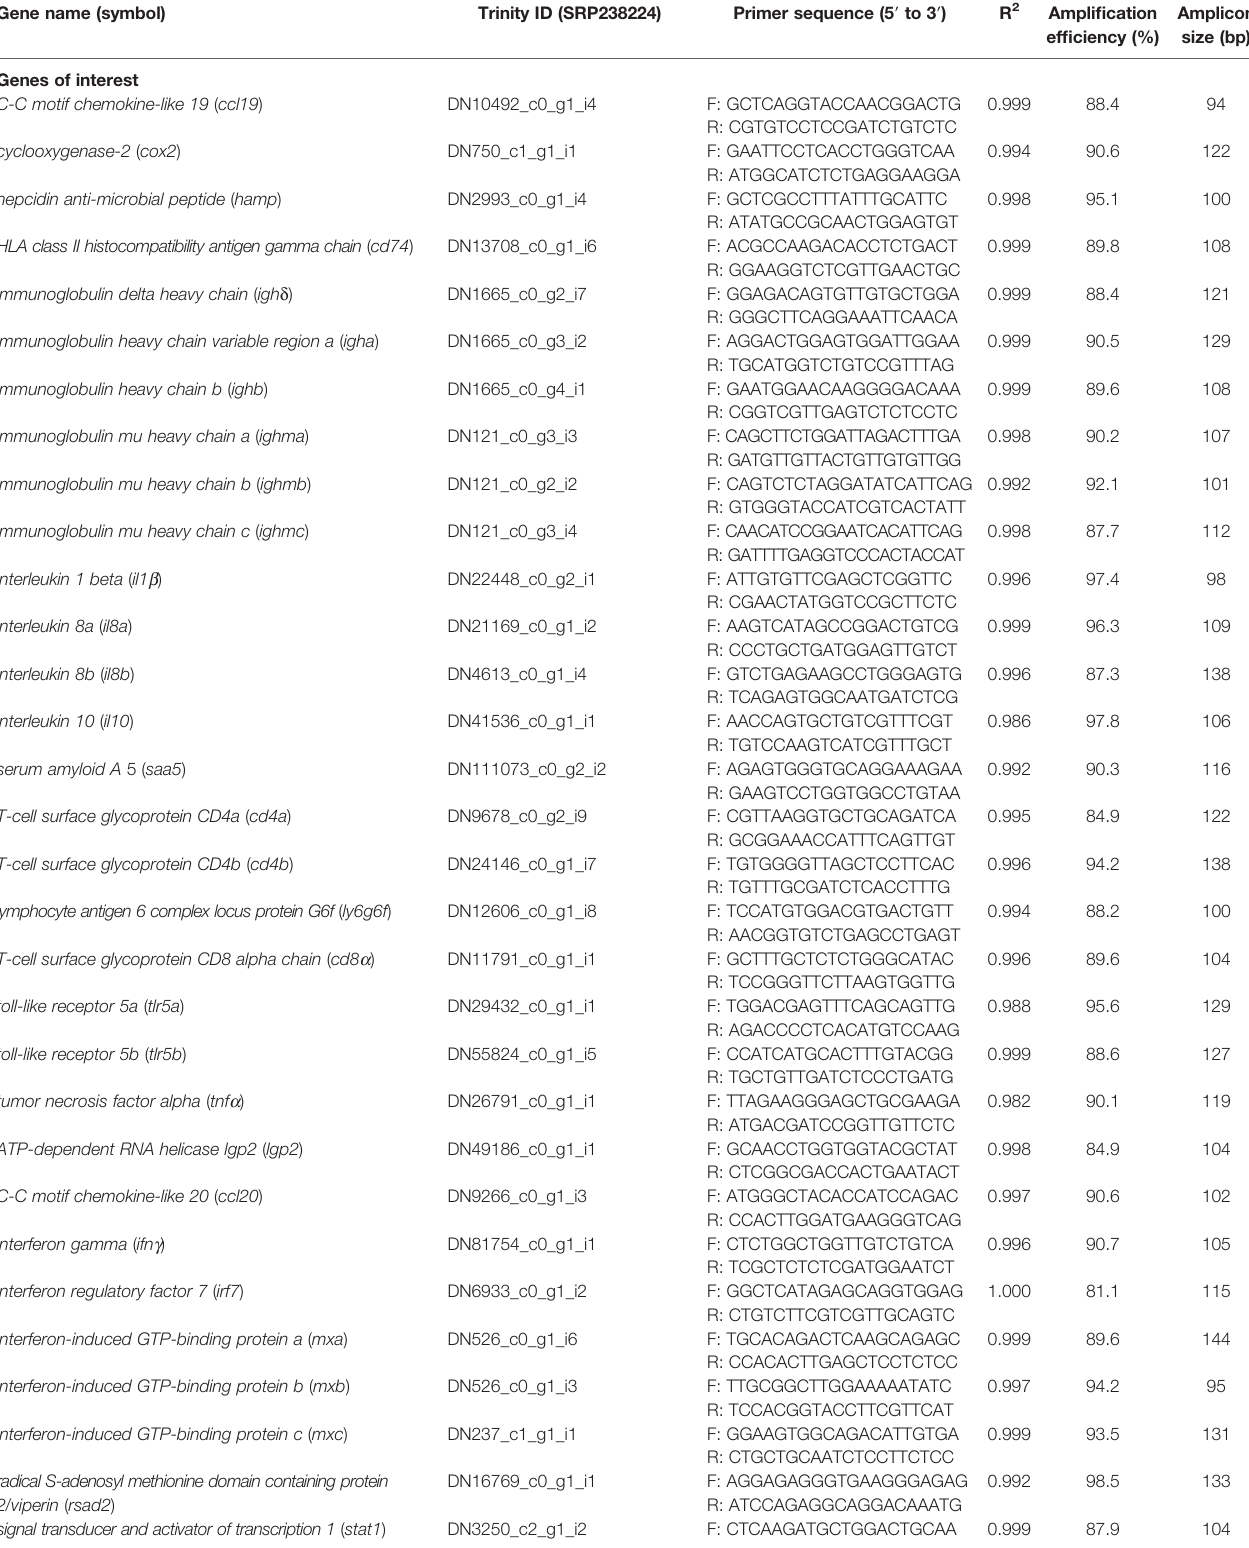
TABLE 1 | qPCR primers used in this